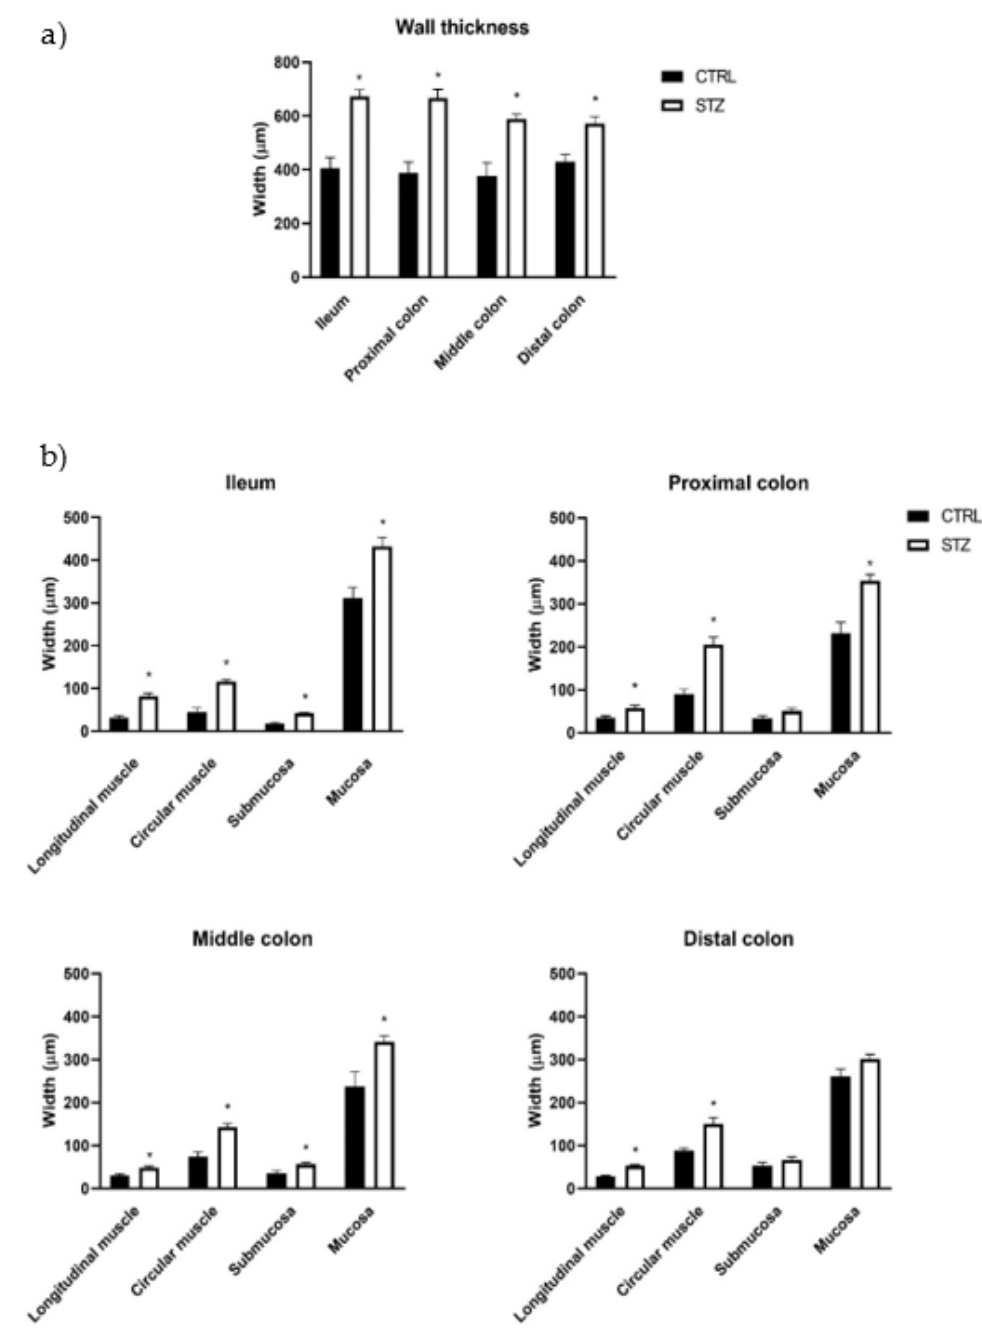
Figure 4. Morphometric evaluation of intestinal segments (ileum, proximal colon, middle colon and distal colon) of control (CTRL, n = 4) and streptozotocin-induced diabetic (STZ, n = 8) rats: ( a ) total wall thickness ( µ m) of each intestinal segment; ( b ) thickness ( µ m) of the intestinal layers (longitudinal muscle, circular muscle, submucosa and mucosa) of each intestinal segment. Values are mean ± SEM and a 2-way ANOVA followed by an unpaired t test with Welch’s correction was used to compare the two experimental groups (CTRL and STZ). * Statistical difference p < 0.05 vs. correspondent control.